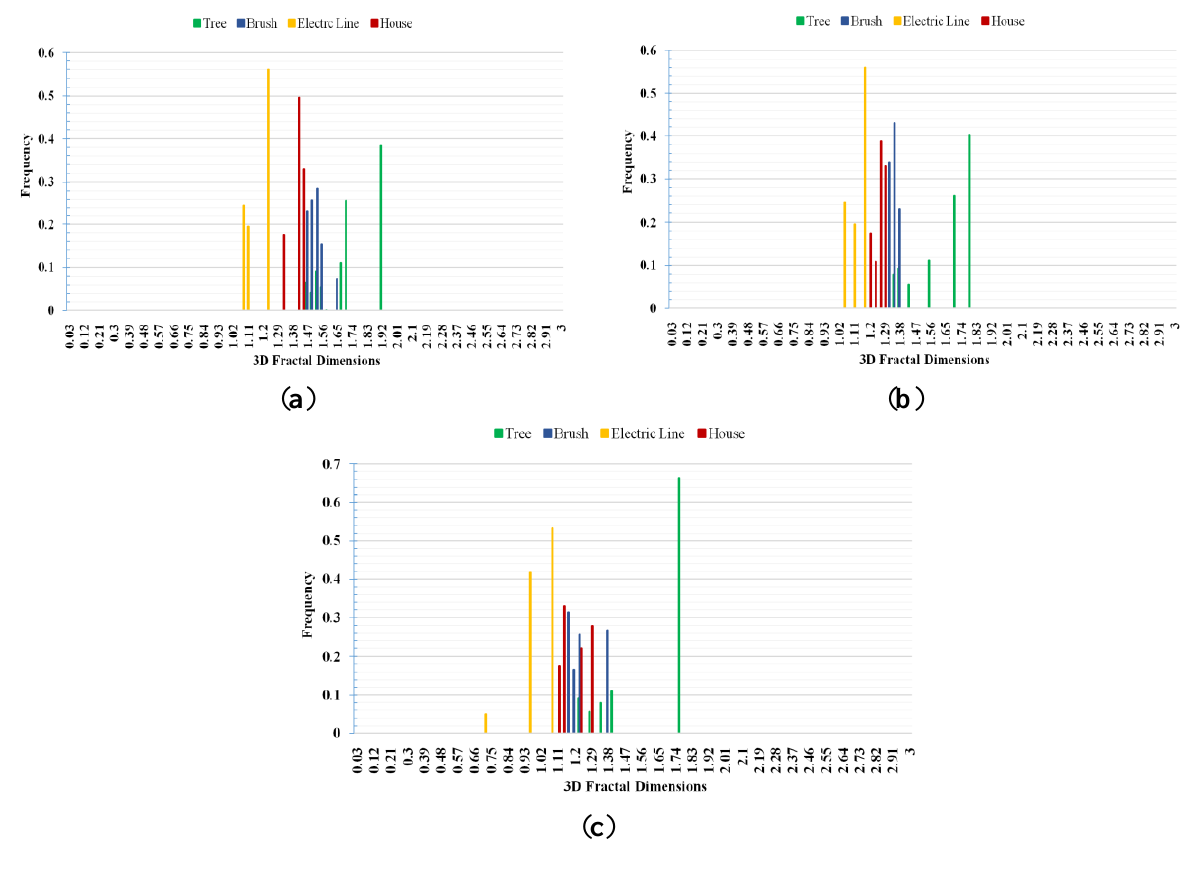
Figure 7. Statistil graphs of diverse features’ 3D fractal dimension distributions: ( a ) high-density; ( b ) medium-density; ( c )